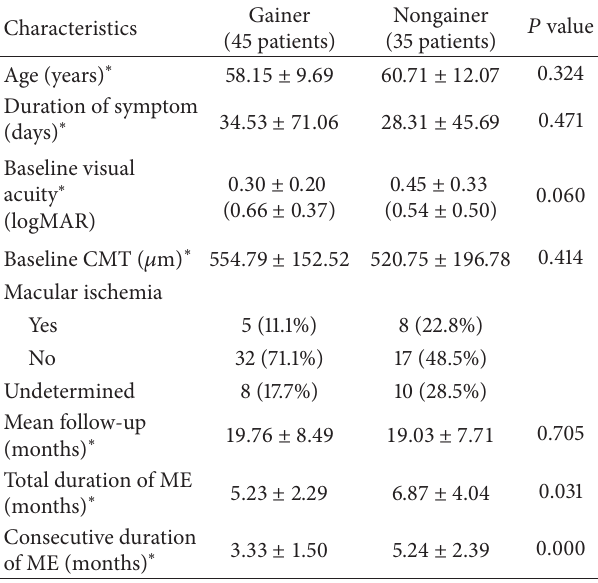
Table 4: Evaluation of prognostic factors between the 2 groups.